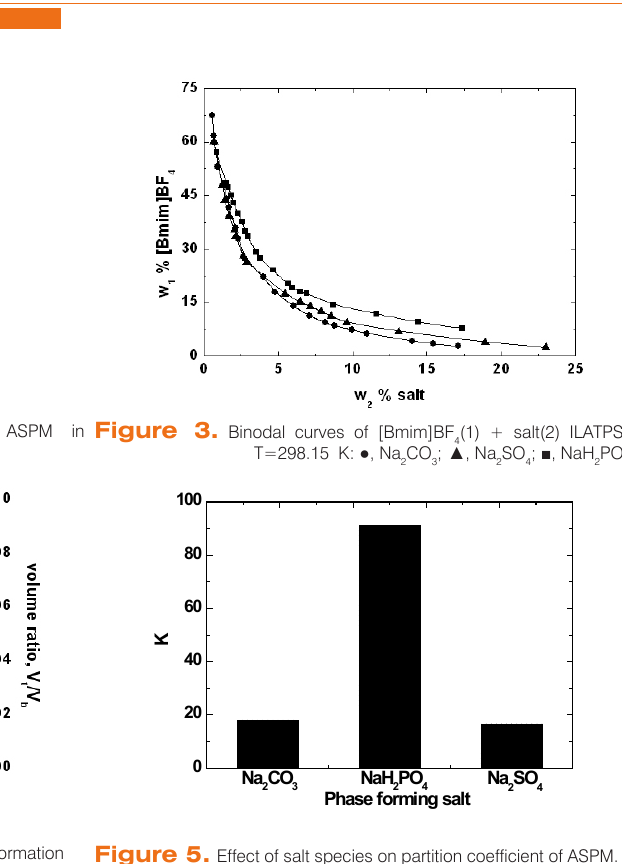
of the [Bmim]BF 298.15 [Bmim]BF